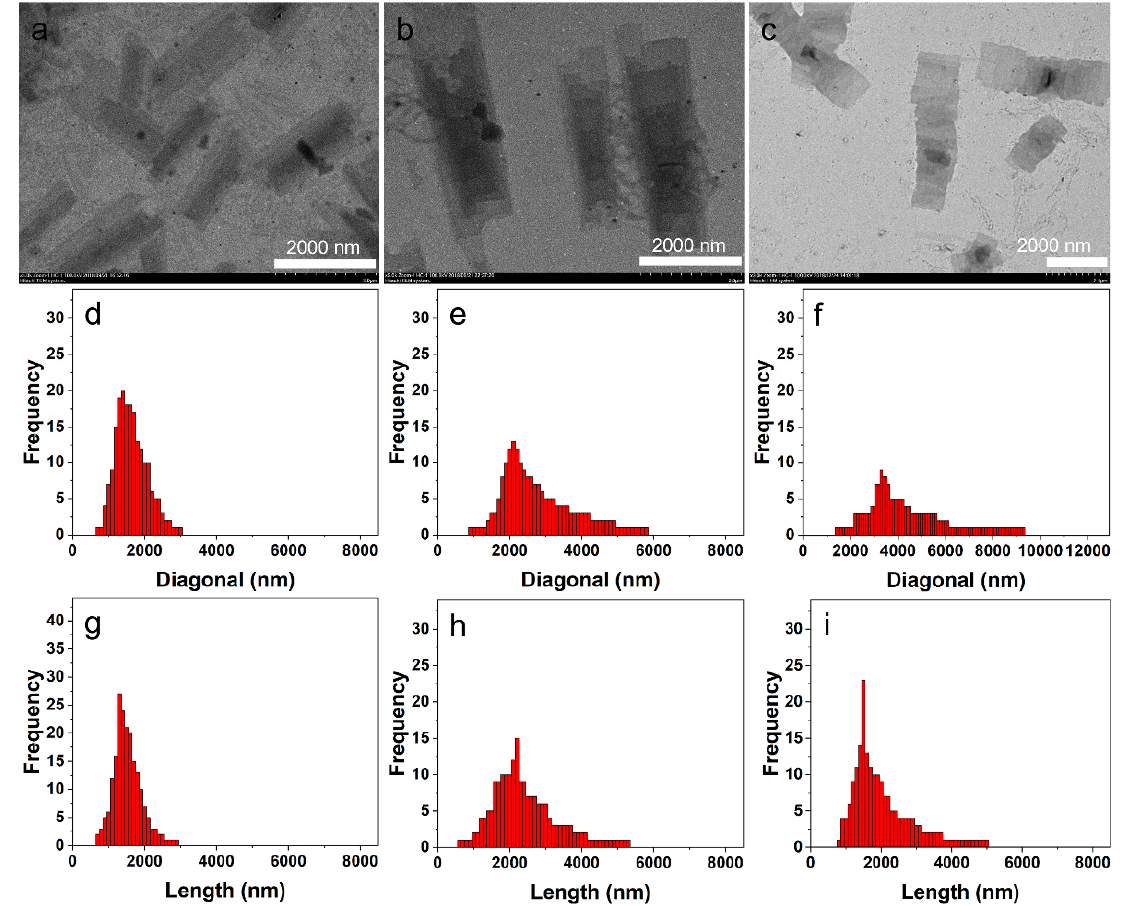
Figure 5. The TEM images and size distributions of the nanostructures self-assembled by P3HT 22 - b -PEG 43 in i -PrOH with different polymer concentrations. TEM images of the multilayered hierar- chical micelles in solutions at c = 0.001 mg . mL − 1 ( a ), c = 0.015 mg . mL − 1 ( b ), and c = 0.03 mg . mL − 1 ( c ). The diagonal length distributions of the multilayered hierarchical micelles in solutions at c = 0.001 mg . mL − 1 ( d ), c = 0.015 mg . mL − 1 ( e ), and c = 0.03 mg . mL − 1 ( f ). The length distributions of the 2D laminar layers included in multilayered hierarchical micelles in solutions at c = 0.001 mg . mL − 1